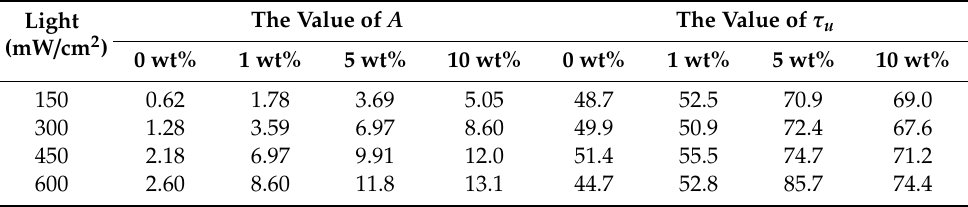
Table 4. Summary of A and τ u obtained by fitting to the exponential model for unbending.